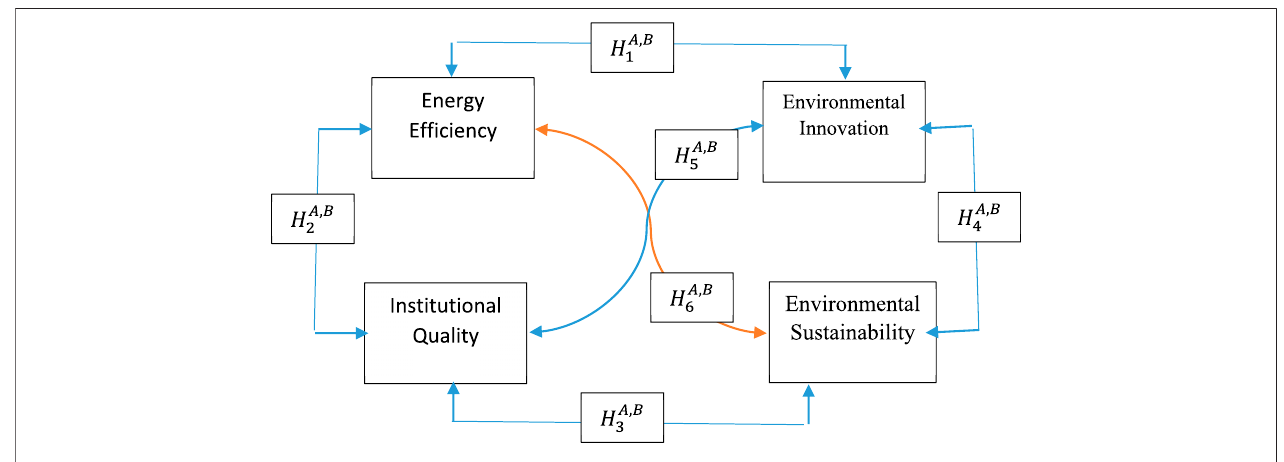
FIGURE 3 | Conceptual model for the study for hypothesis